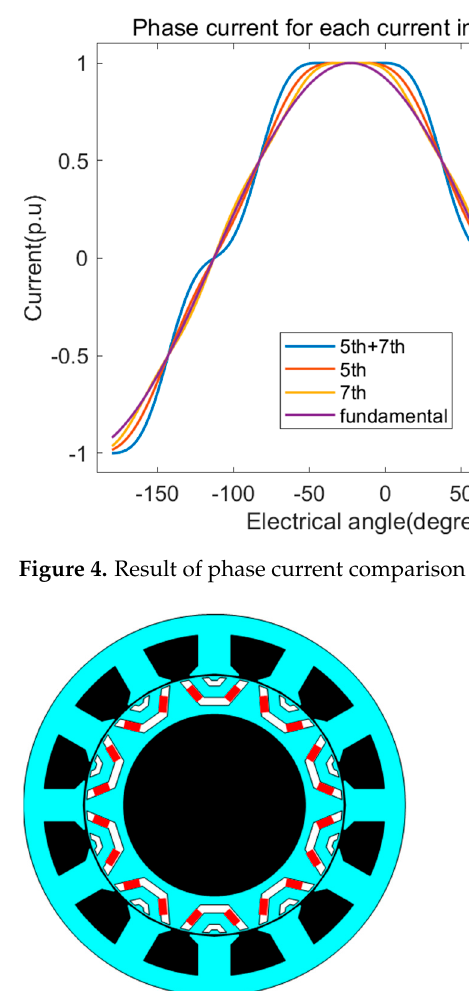
Figure 4. Result of phase current comparison with optimized coefficients.